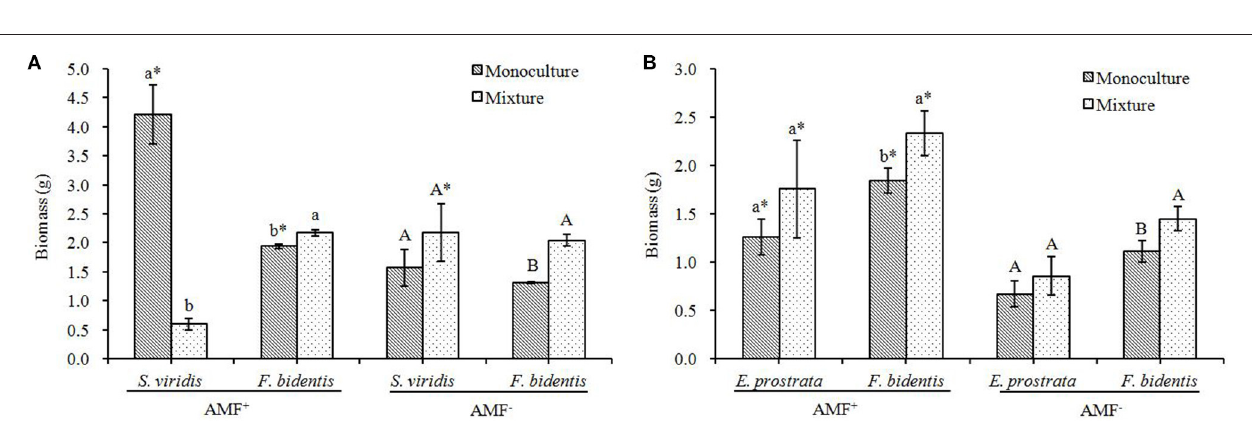
FIGURE 2 | The colonization rate of exotic plant F. bidentis and two native plants S. viridis (A) and E. prostate (B) when grown in monoculture or in mixture. Different lower case letters indicate significant difference between monoculture and mixture treatments at P < 0.05. Error bar represent ± SE of mean ( n = 10).